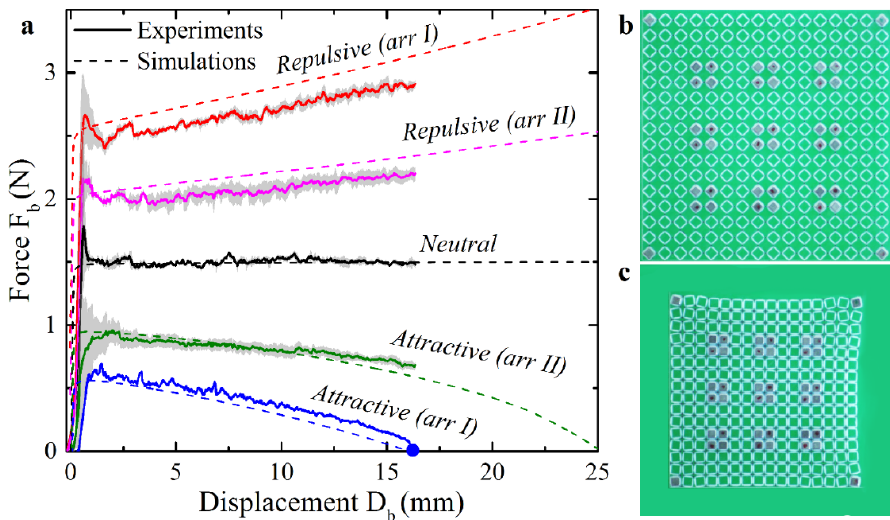
Figure 6. ( a ) Force–displacement curves obtained experimentally (solid lines) and numerically (dashed lines) for finite 16 × 16 metamaterials with arrangements I and II. Solid lines show the means for three consecutive loadings of the metamaterial, while gray areas correspond to the standard deviation. ( b , c ) Two stable states of the metamaterial (arrangement I), observed experimentally. The snap-through occurs at the displacement marked by the blue circle (Figure 6a).